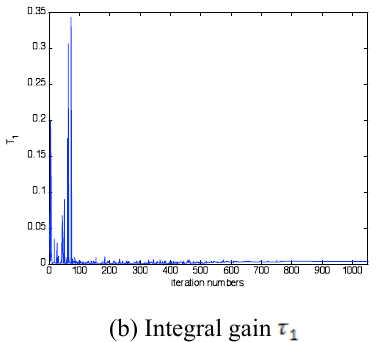
Fig. 9. Evolution of the cost function and